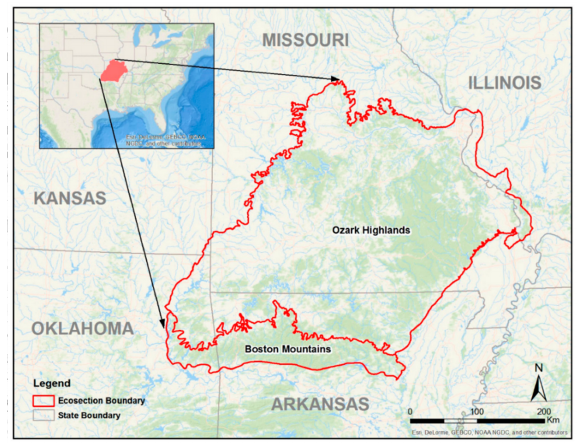
Figure 1. Location of the study